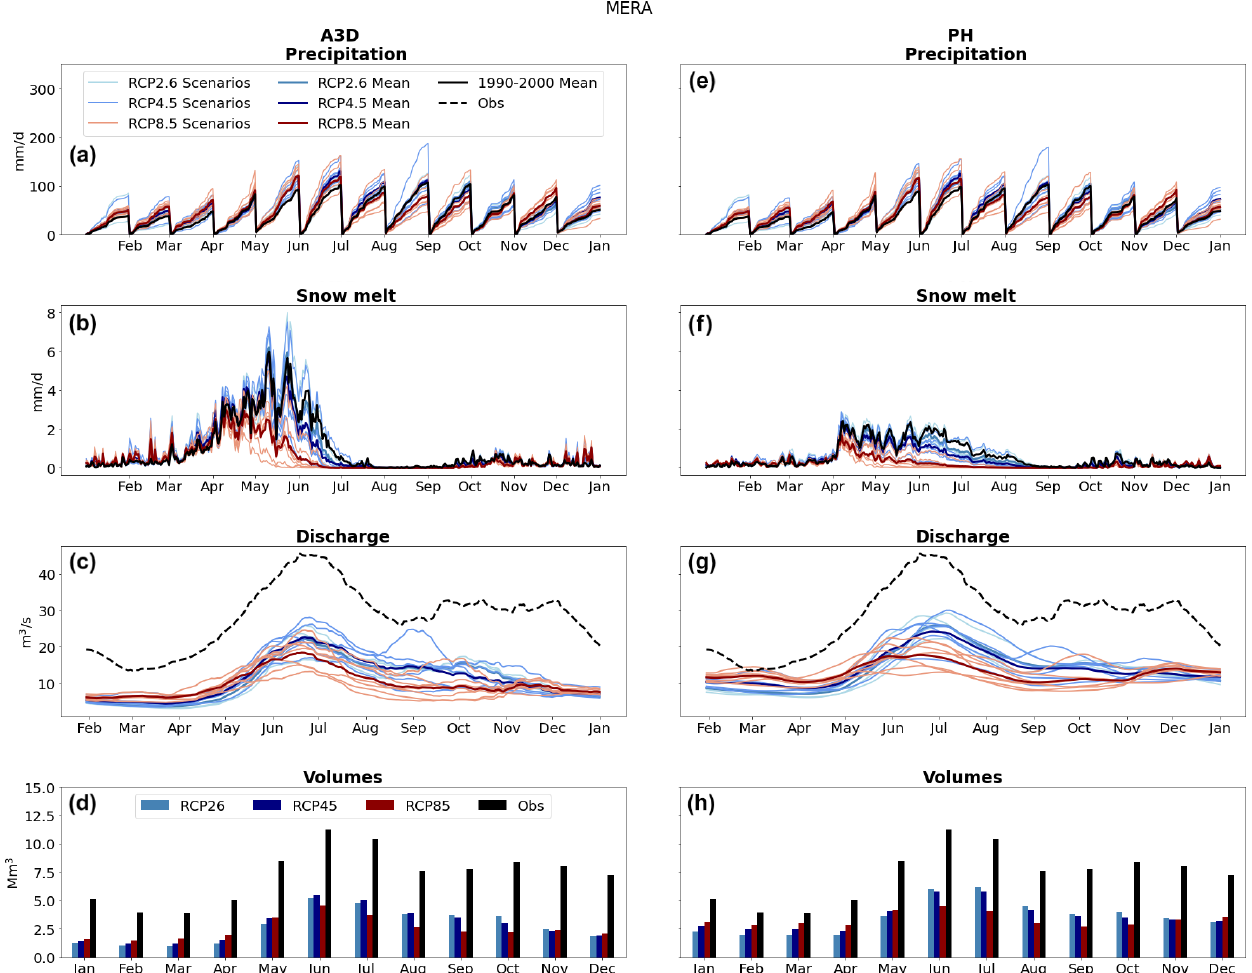
Figure 9. Climate change scenarios over the Mera catchment for 2080–2090 against the reference mean over 1990–2000 for precipitation (a) , snowmelt (b) , discharge (c) and volumes (d) predicted by A3D (a–d) and PH (e–h) . Precipitation and volumes are presented as average monthly cumulates. Snowmelt is presented as the average year. Discharge is presented as the average year, smoothed by a moving average with a window of